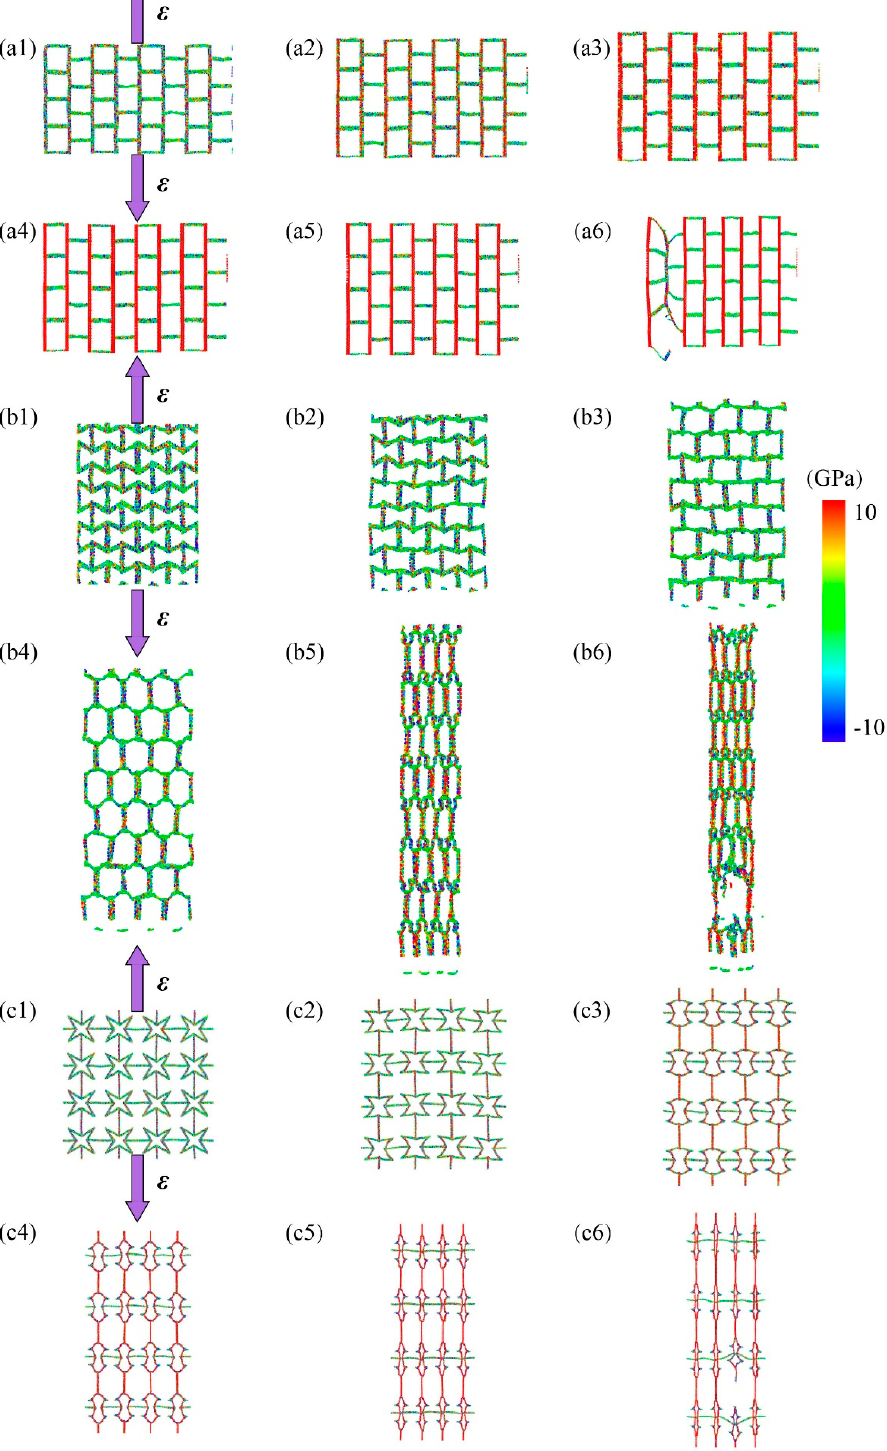
Figure 4. Configuration deformation and stress distribution of KGSs for system under tensile loading along the y-direction. ( a1 – a6 ) is process of the SKG’s model deformation and stress distribution under tensile loading. ( b1 – b6 ) is process of the RHH’s model deformation and stress distribution under tensile loading. ( c1 – c6 ) is process of the QSS’s model deformation and stress distribution under tensile